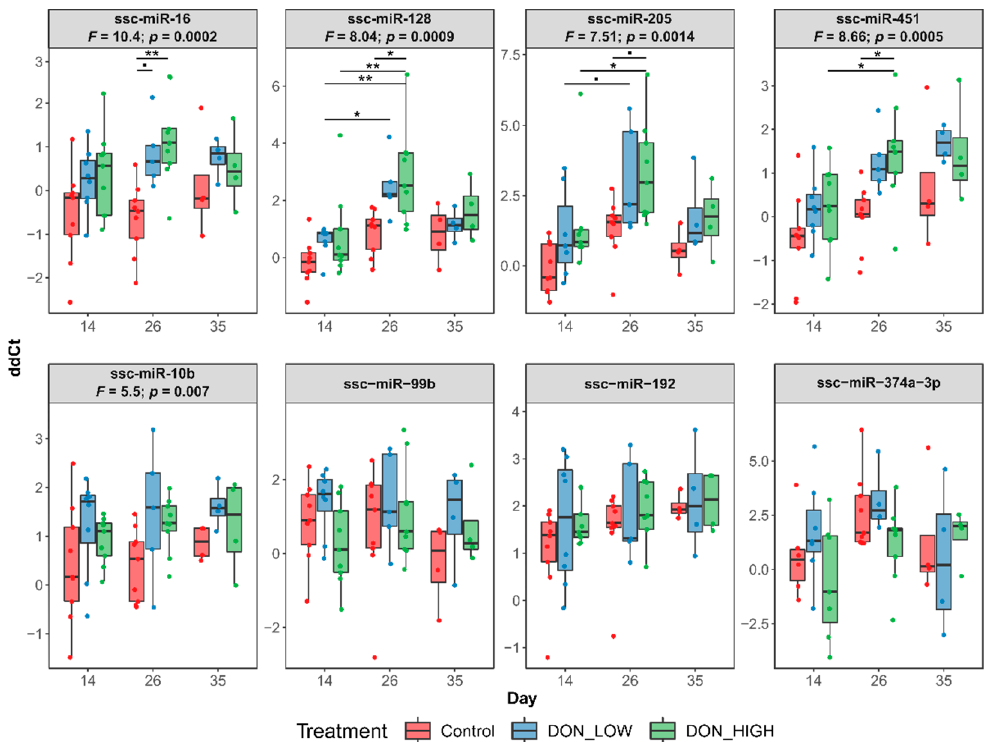
Figure 5. MicroRNA expression in the serum based on qPCR. Comparison of microRNA expression in different treatment groups, normalized by the baseline expression at d0. Significant values for the treatment effect are shown above each plot based on 2-way ANOVA followed by Tukey’s multiple comparison test. Significant differences are marked as follows: ■ p < 0.1; * p < 0.01; ** p < 0.001.